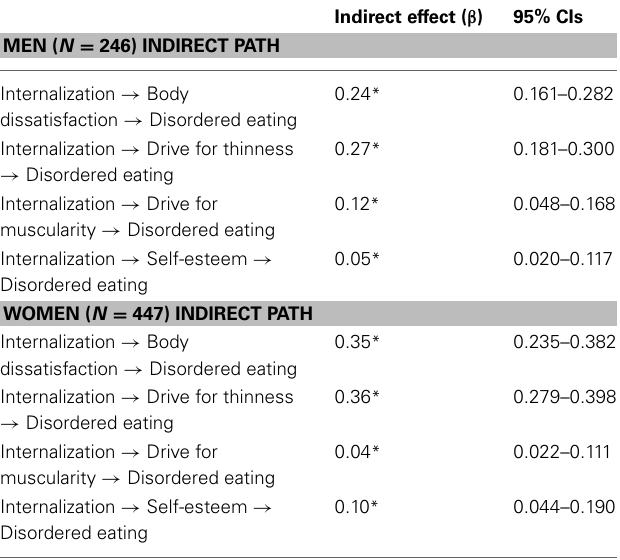
Table 6 | Mediation: examination of indirect effects and bias-corrected 95% confidence intervals (CIs).